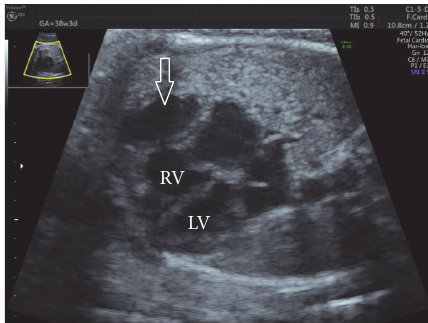
Figure 1: Fetal ultrasound: four-chamber view showing the diver- ticulum arising from the right ventricle. LV, left ventricle; RV, right ventricle.